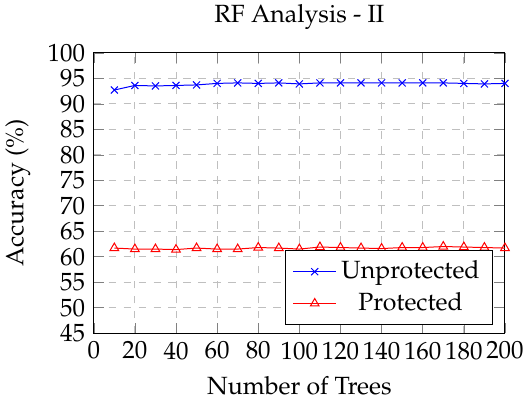
Figure 7. Analysis of number of Trees value on accuracy for RF